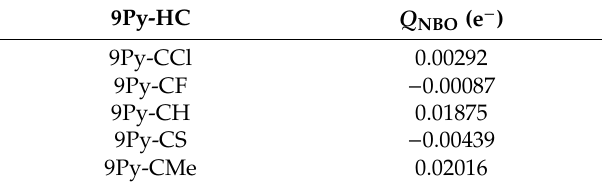
Table 5. NBO charge transfer analysis for the heterocarbonyl (HC) gases in the 9Py-HC